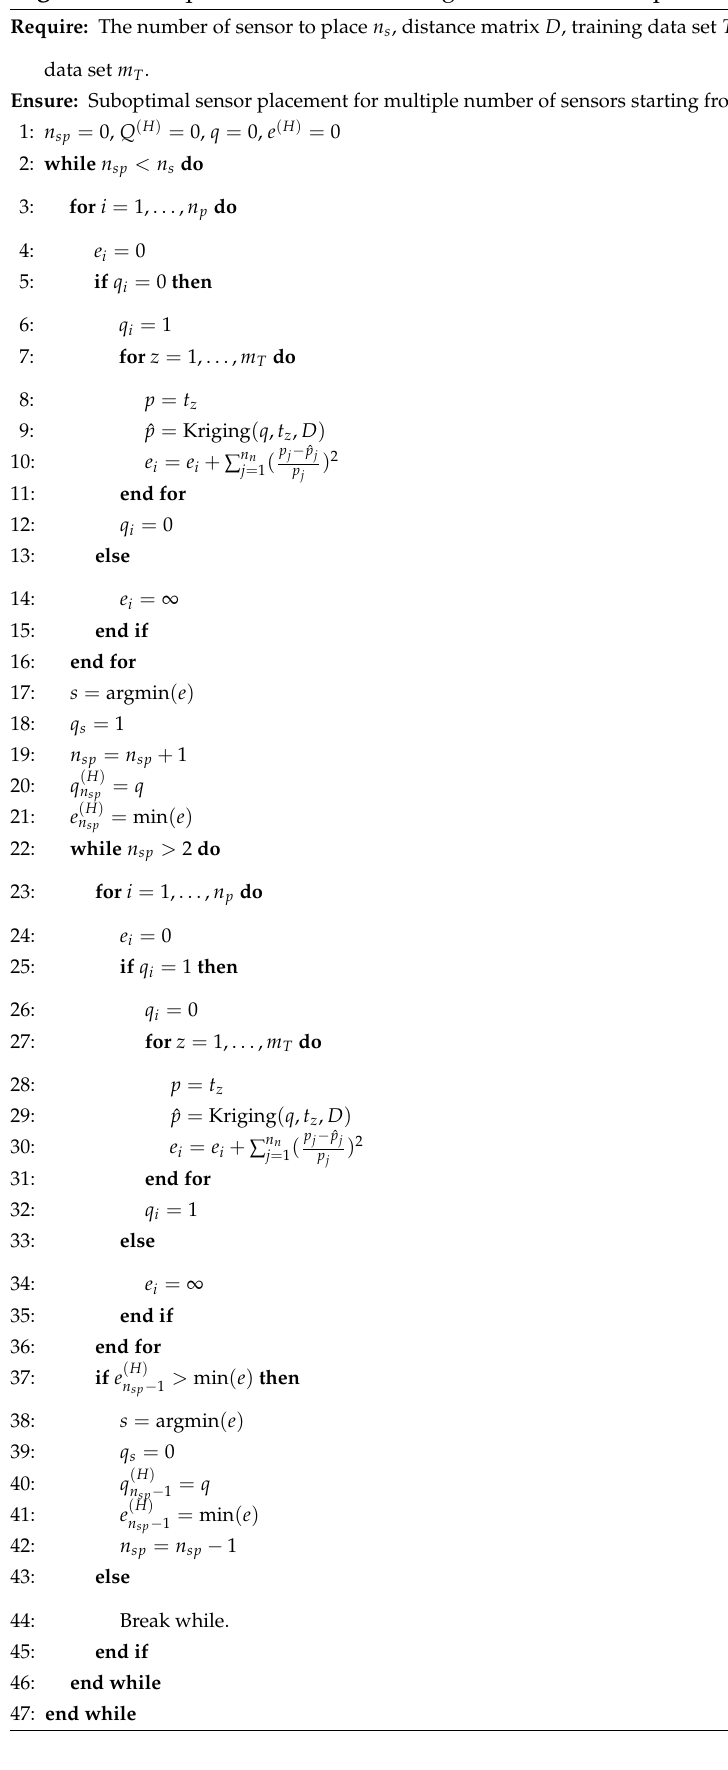
Algorithm 1 Sequential forward floating search for sensor